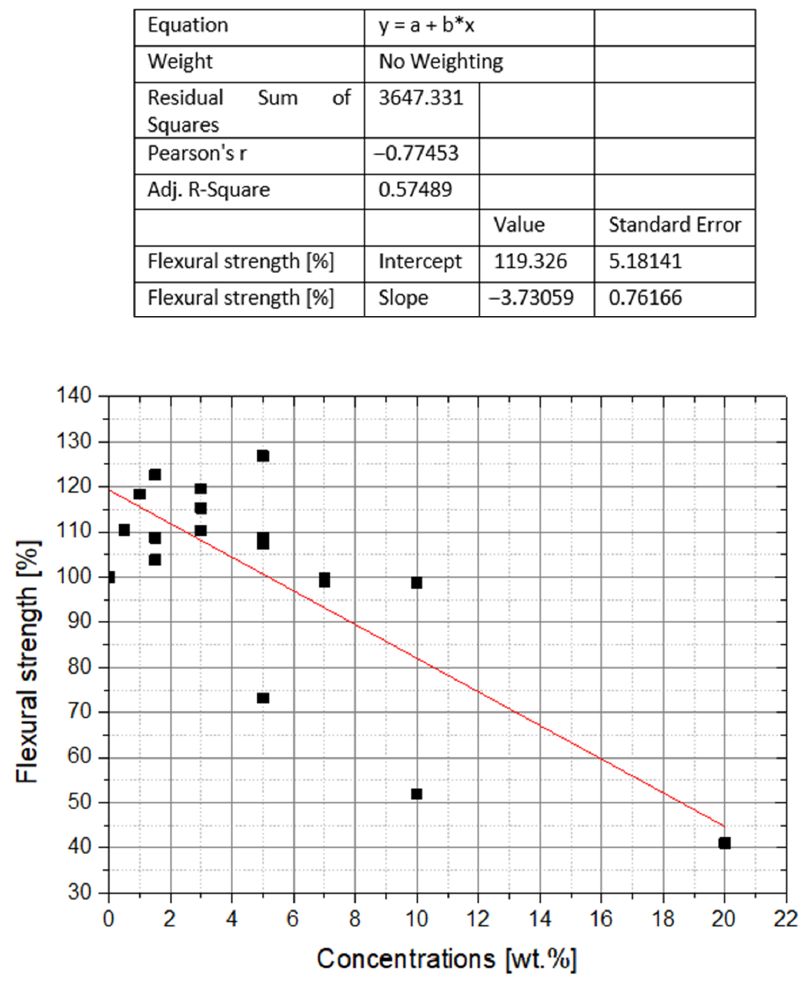
Figure 2. The effect of nano-ZrO 2 additive concentration on the flexural strength of PMMA composites. The results of individual studies.